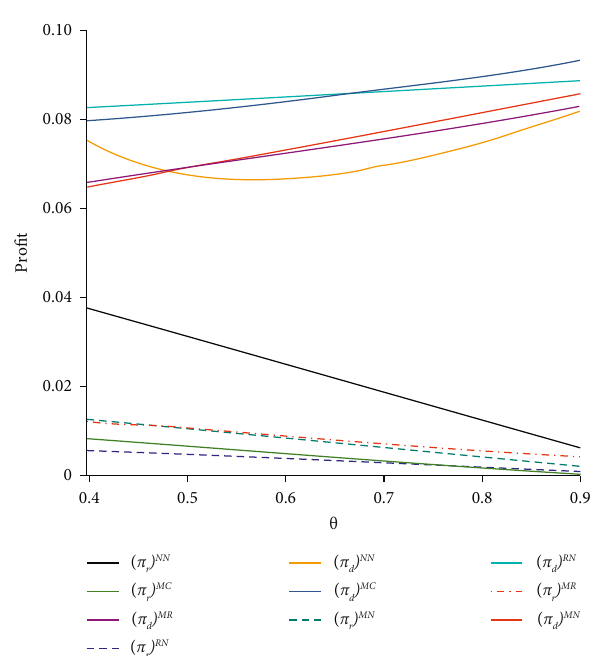
Figure 2: Effect of θ on optimal